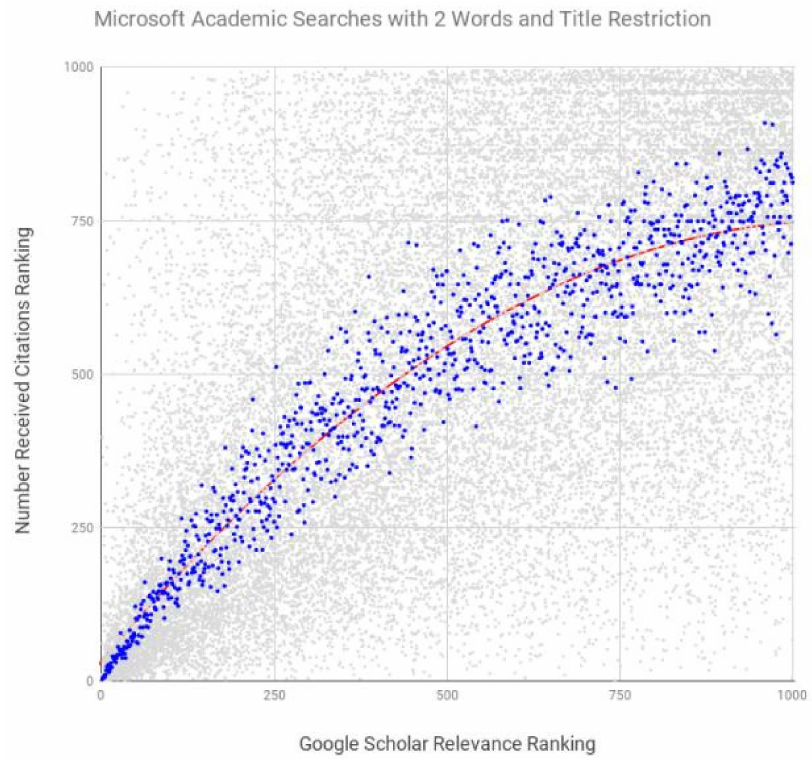
Figure 6. Microsoft Academic Searches with Two Words and Title Restriction (rho 0.937, median in blue, the rest of data in